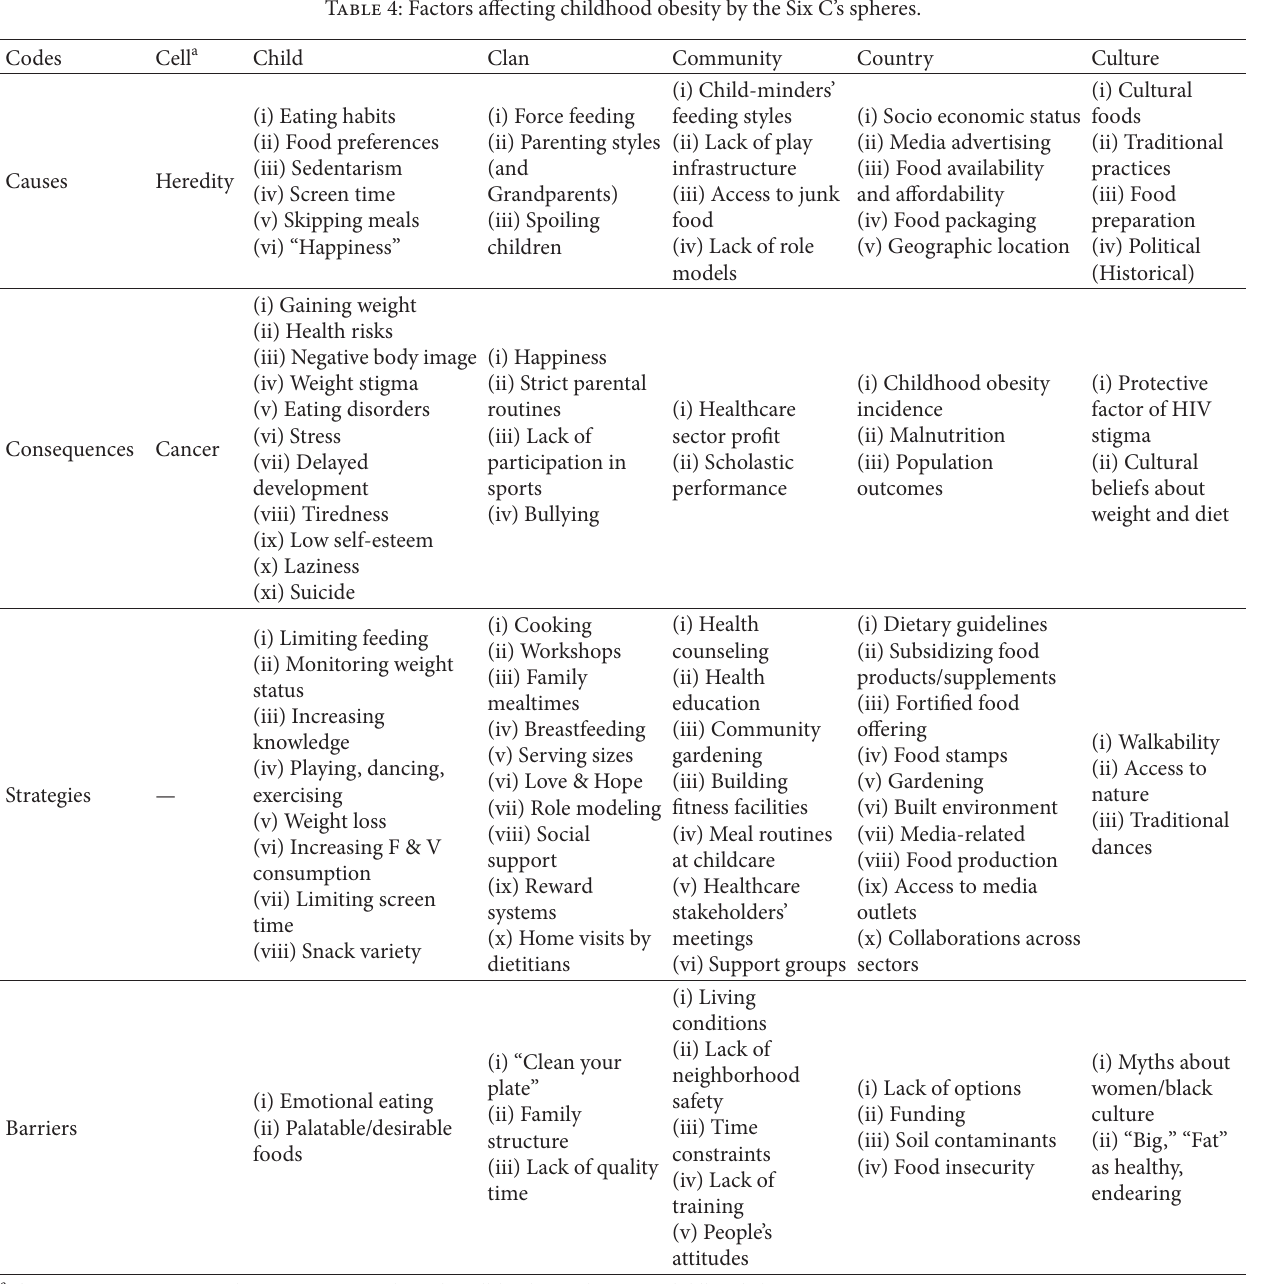
Table 4: Factors affecting childhood obesity by the Six C’s